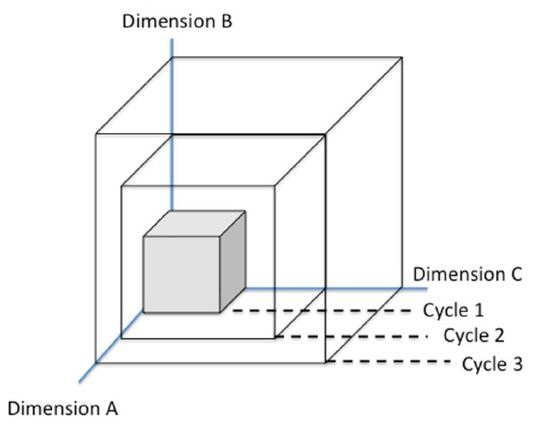
Figure 1. Representation of competence dimensions